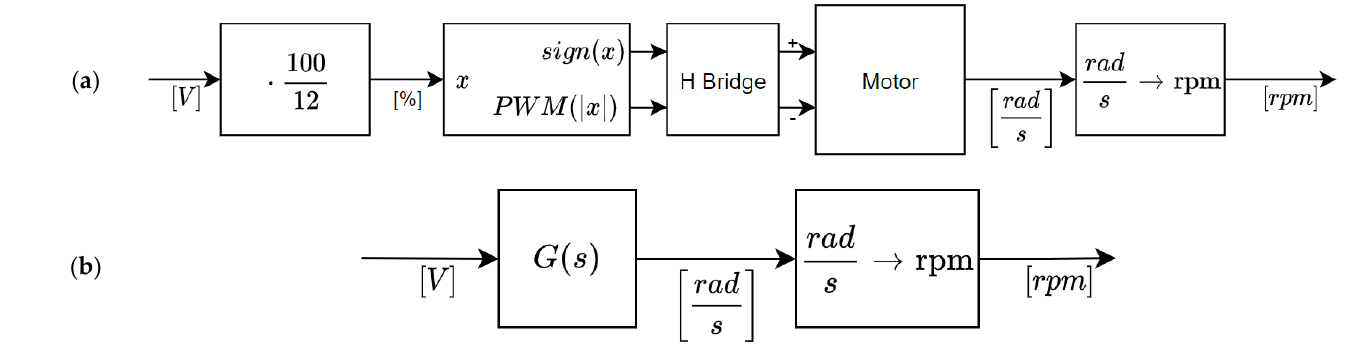
Figure 13. ( a ) Real motor setup. ( b ) Simulation of the motor model.